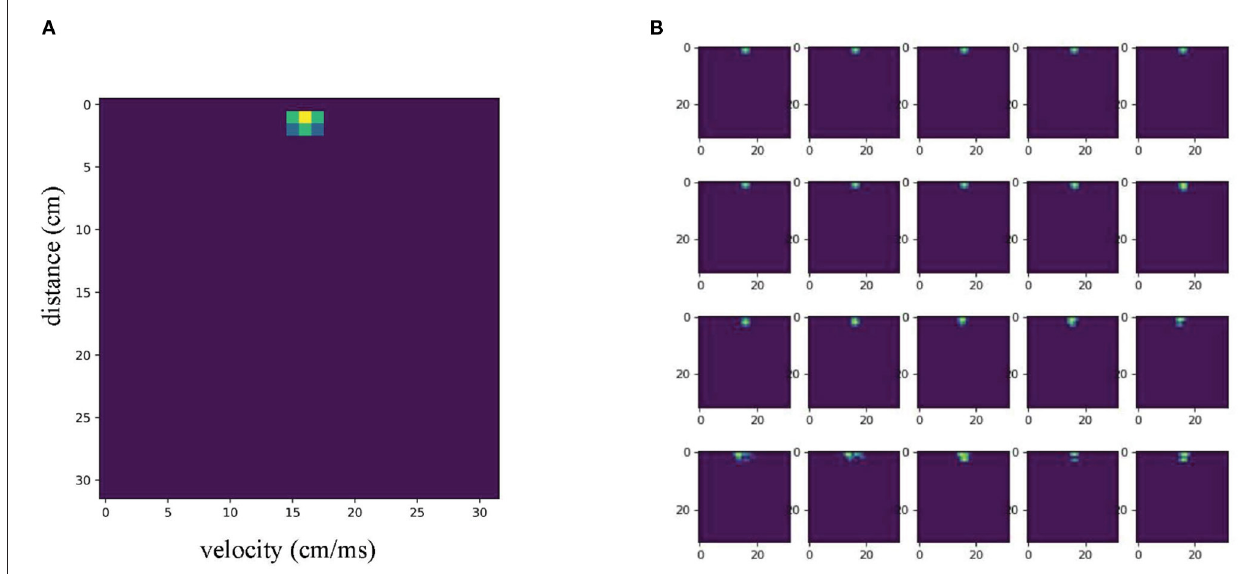
FIGURE 1 | (A) An random example of the dataset, (B) 20 frames of selected images for this example.